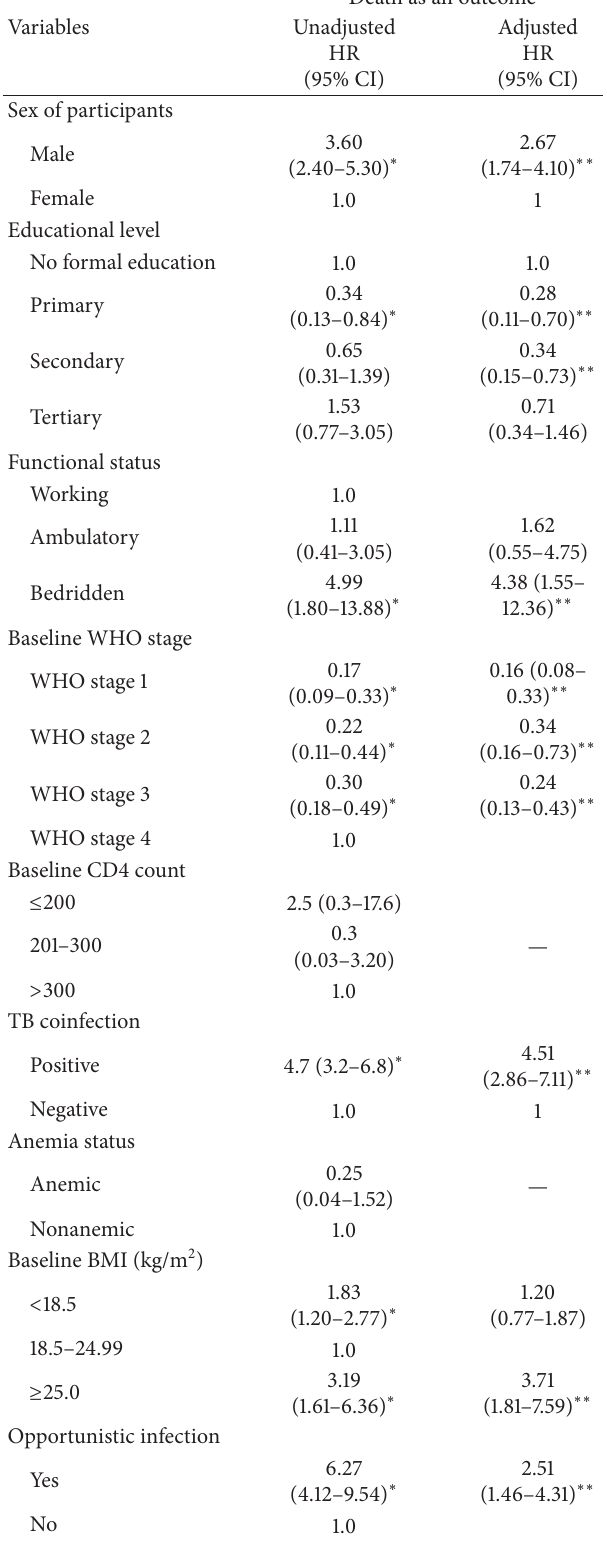
Table 3: Cox regression model: Selected sociodemographic and clinical factors associated with mortality of ART clients in Goba Hospital, Southeast Ethiopia,